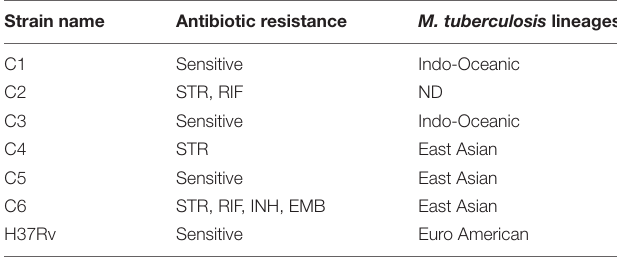
TABLE 1 | Mycobacterium tuberculosis clinical strains selected for the study based on antibiotic sensitive and resistant